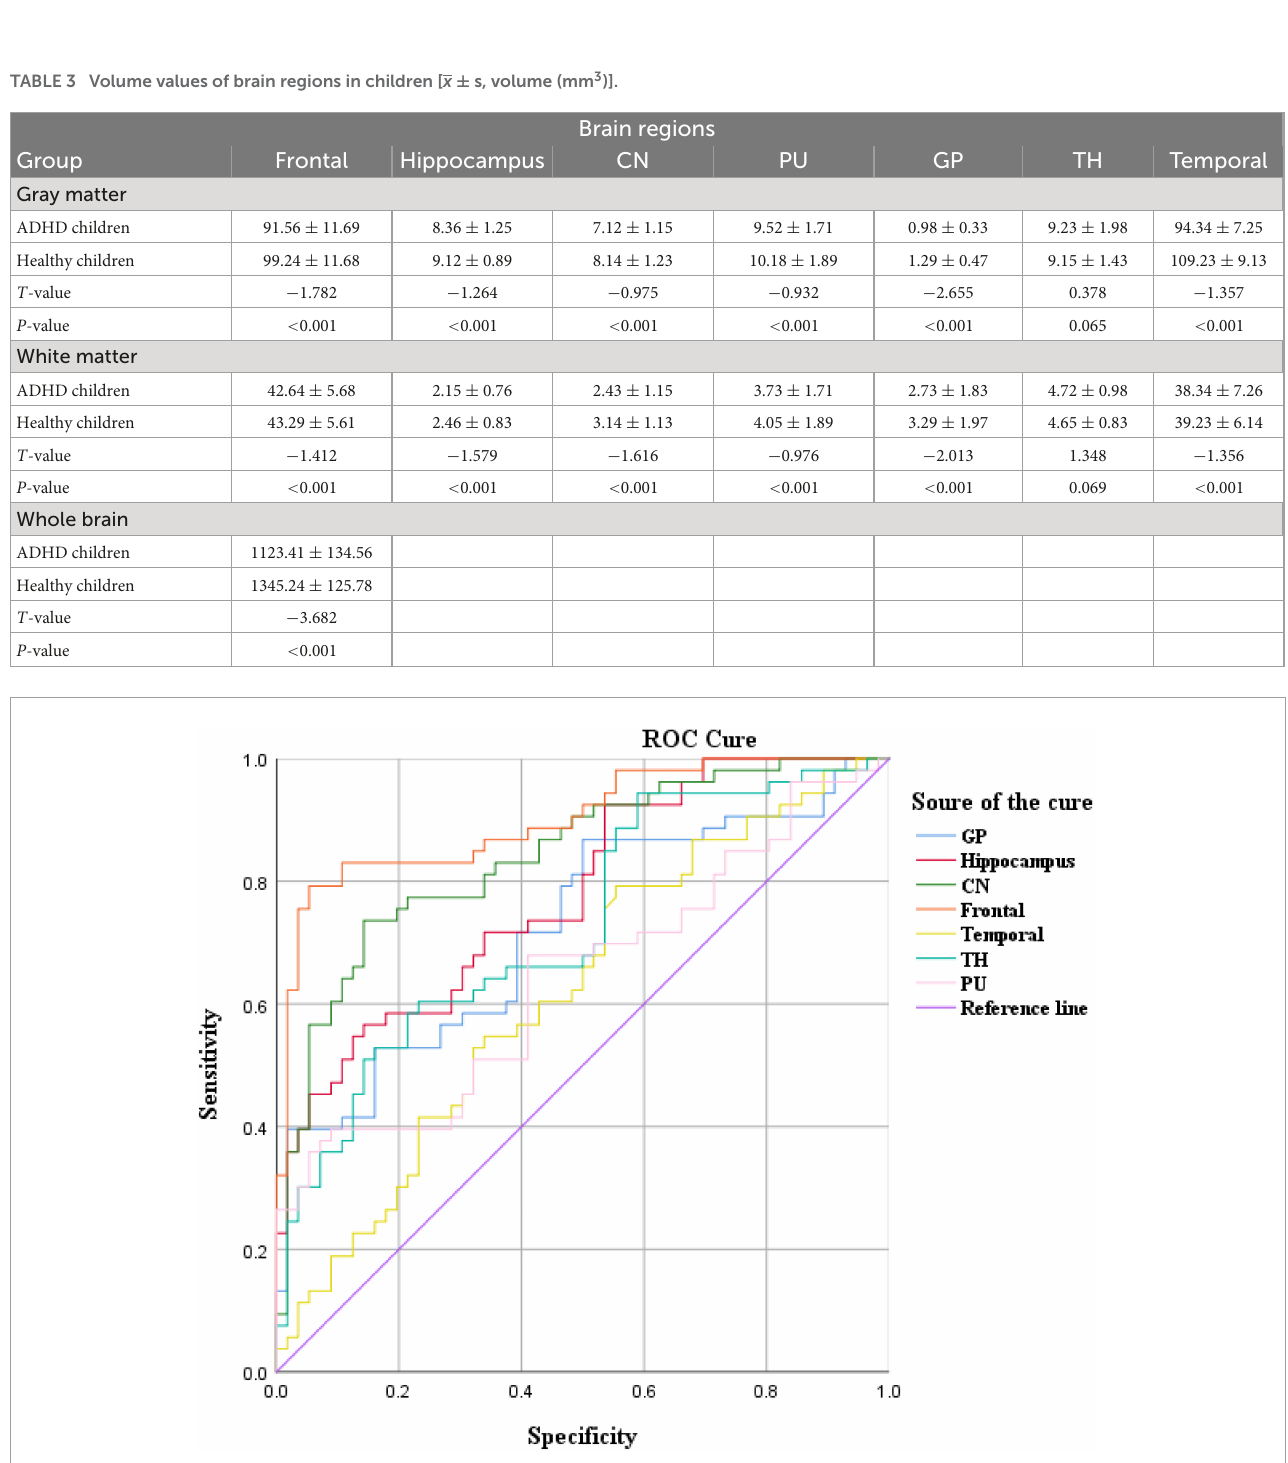
FIGURE4 Receiver operating curve (ROC) curve analysis results of CBF in brain regions.